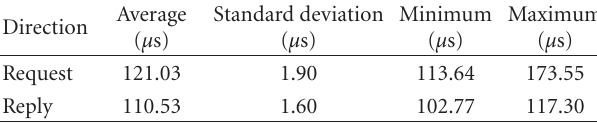
Table 7: Query and response times for 3600 NTP requests between two computers connected by an unmanaged Ethernet switch. All times are in microseconds.